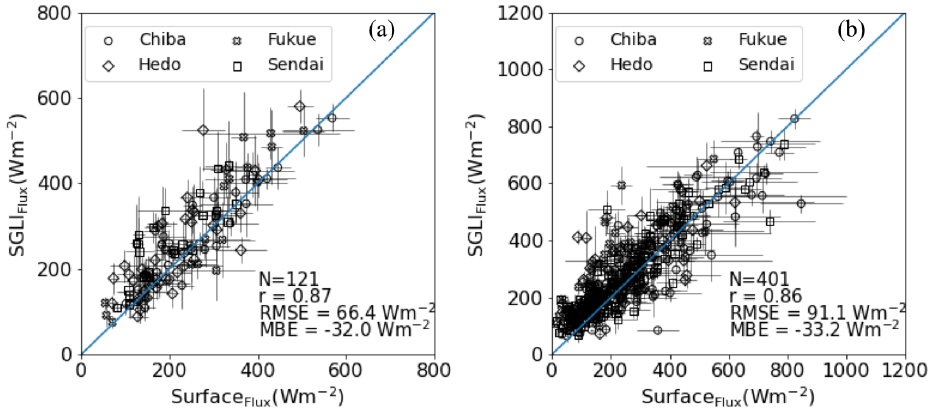
Figure 11. Comparison of surface-observed global irradiances with values modeled using SGLI-observed cloud properties for (a) water clouds and (b) ice clouds.